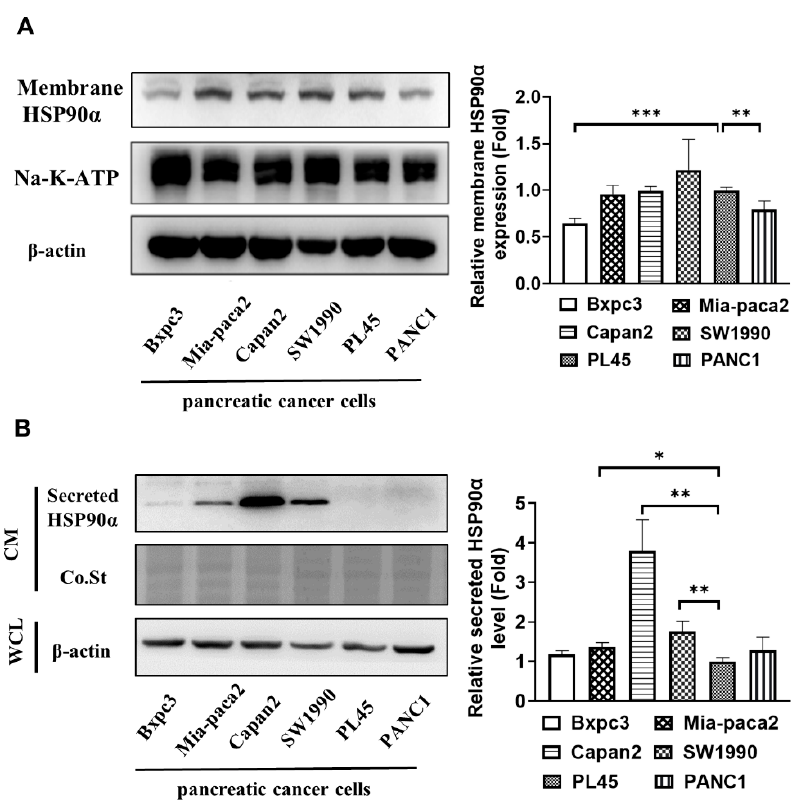
Figure 1. The levels of secreted HSP90 α elevate in invasive PC cells. ( A ) A total of 5 × 10 6 PC cells were plated overnight, then membrane proteins were isolated using a Thermo Scientific Mem-PER Plus membrane protein extraction kit, and the surface HSP90 α level was detected by Western blot analysis. ( B ) A total of 5×10 6 PC cells were seeded in a 10 cm dish with serum starvation for 24 h, and cell supernatants were filtered through 0.45 μ M filters and concentrated by an Amicon Ultracel-30k centrifugal filter (Millipore) for equal volume. The secreted HSP90 α levels were detected by Western blot analysis. The relative HSP90 α protein levels in the cell surface or supernatant are shown in the histogram. CM: conditional medium, Co.St: Coomassie stain, and WCL: whole cell lysates. Data are expressed as the mean ± SD from three experiments. * p ≤ 0.05, ** p ≤ 0.01, and *** p ≤ 0.001.